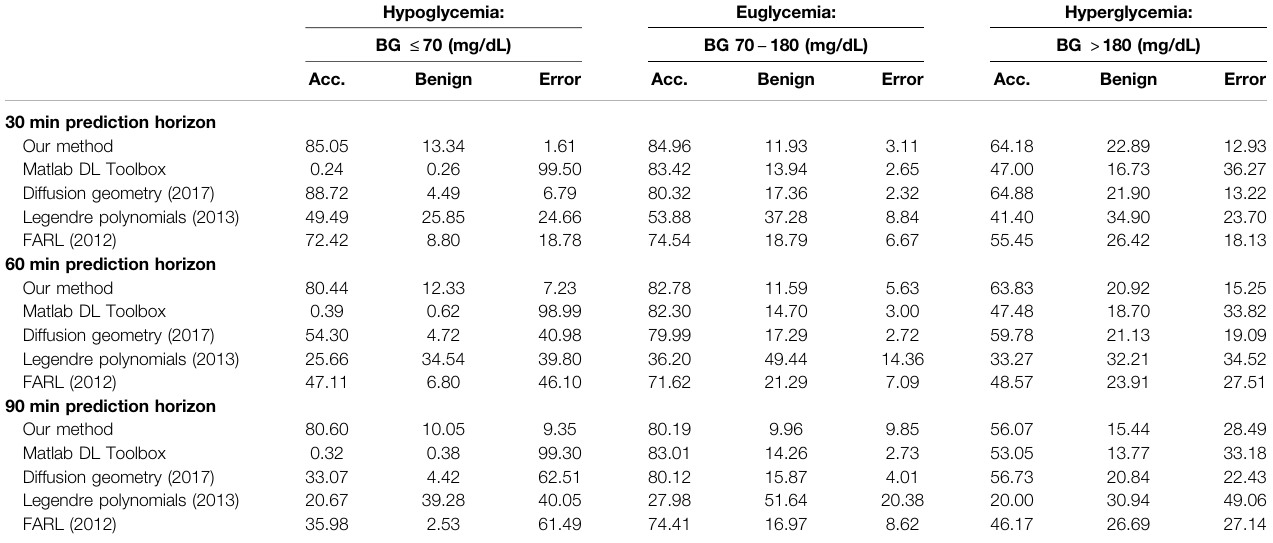
TABLE 3 | Average PRED-EGA scores (in percent) for different prediction horizons on dataset D . Hypoglycemia: Euglycemia: Hyperglycemia: BG ≤ 70 (mg/dL)